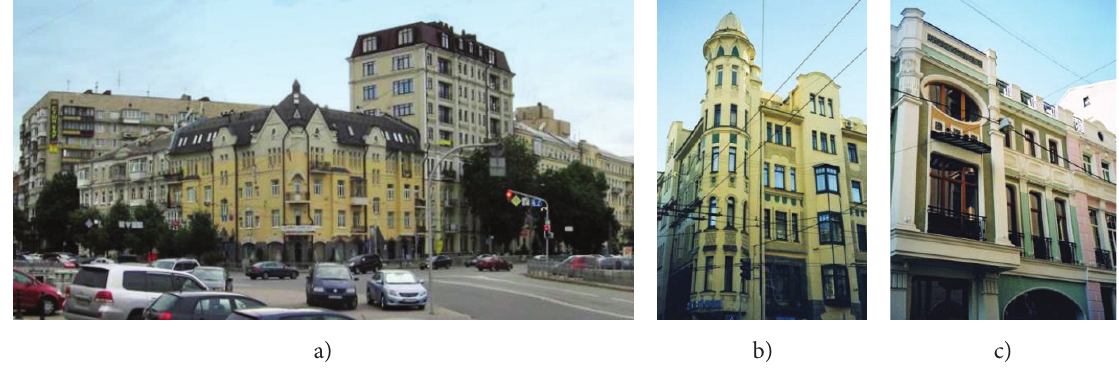
Figure 9. Analogs from Kyiv and Moscow architecture (source: photo by prof. Yulia Ivashko, 2005);